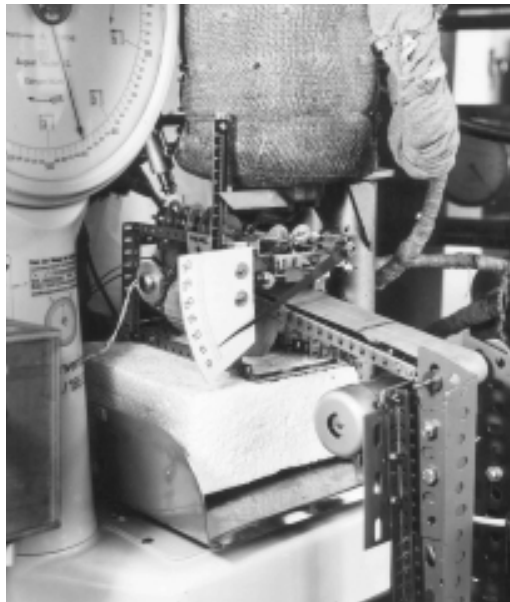
Figure 2 (left): First version of Meissner's rotary clamp elongational rheometer (1968). Figure 3 (right): Prototype of the Rheotens